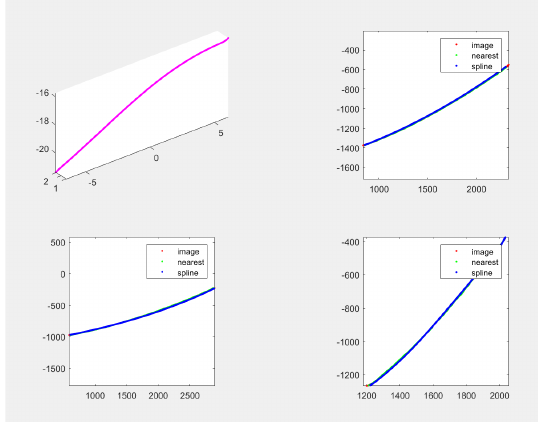
Figure 9. Reconstructed curves and reprojection on three input images (before literation)